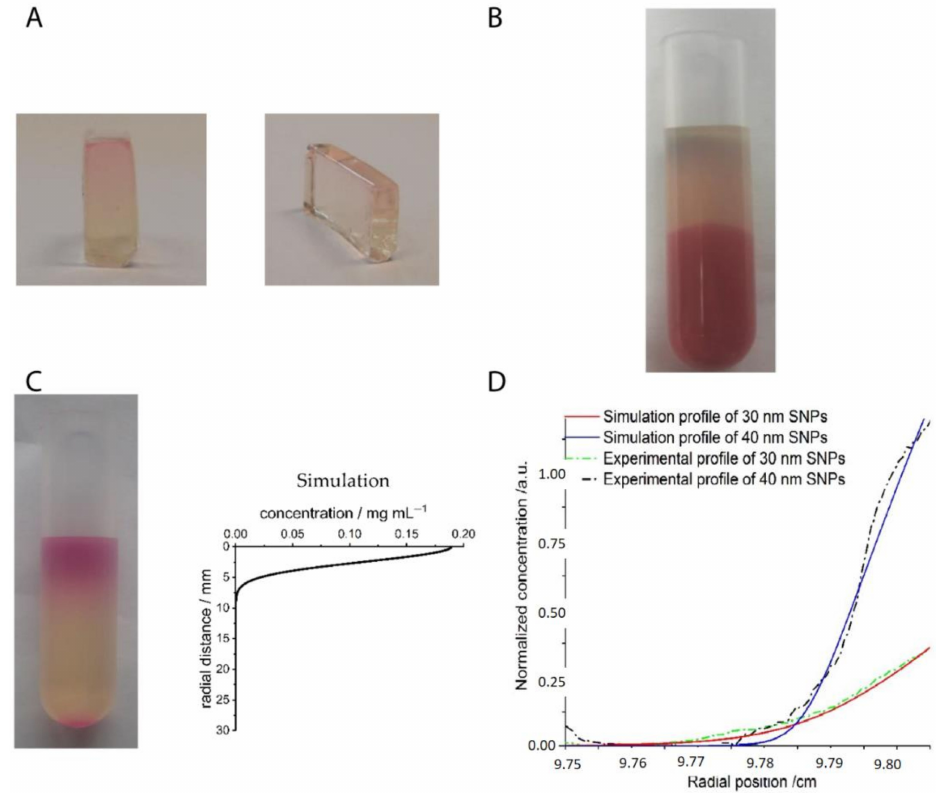
Figure 9. ( A ) A typical piece of nanoparticle gradient material in a gelatin gel matrix made in an AUC cell from two different views with the dimension of 1.2 cm × 0.7 cm × 0.3 cm; ( B ) Typical piece of nanoparticle gradient material made in a cylindrical PUC tube with the length of 3.8 cm and diameter of 1.2 cm; ( C ) Piece of fluorescence labeled silica nanoparticle gradient material obtained after a PUC experiment at 3000 rpm for 20 h in a L-70 preparative ultracentrifuge with the corresponding simulated concentration gradient; ( D ) Normalized experimental (dashed dotted lines) and simulation (solid lines) concentration gradients for a binary hard sphere suspension of 30 nm (3.3 vol%) and 40 nm (6.7 vol%) silica nanoparticles with two different fluorescent labels from a PUC experiment at 2800 rpm in a L-70 preparative ultracentrifuge. The absorbance gradients were measured by a confocal laser scanning microscope (CLSM) and agreed with the simulations. Reproduced with permission from [98], Copyright Wiley-VCH, 2018, and [103], Copyright the American Chemical Society,